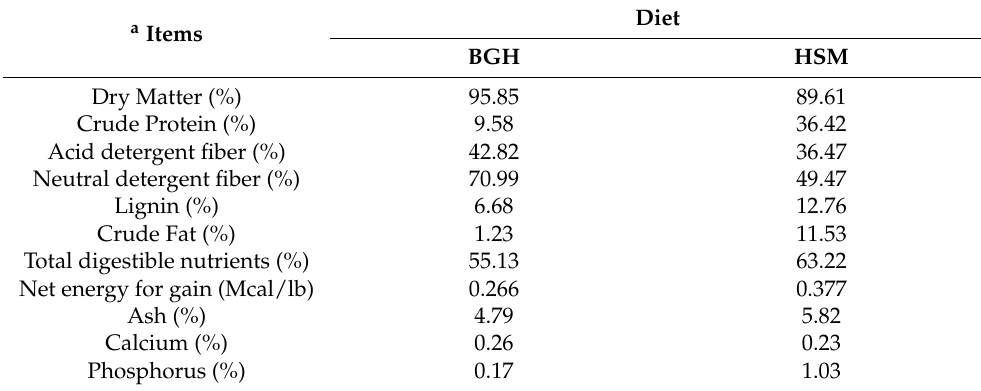
Table 1. Chemical composition of Bermuda grass hay (BGH) and hempseed meal (HSM) used in the